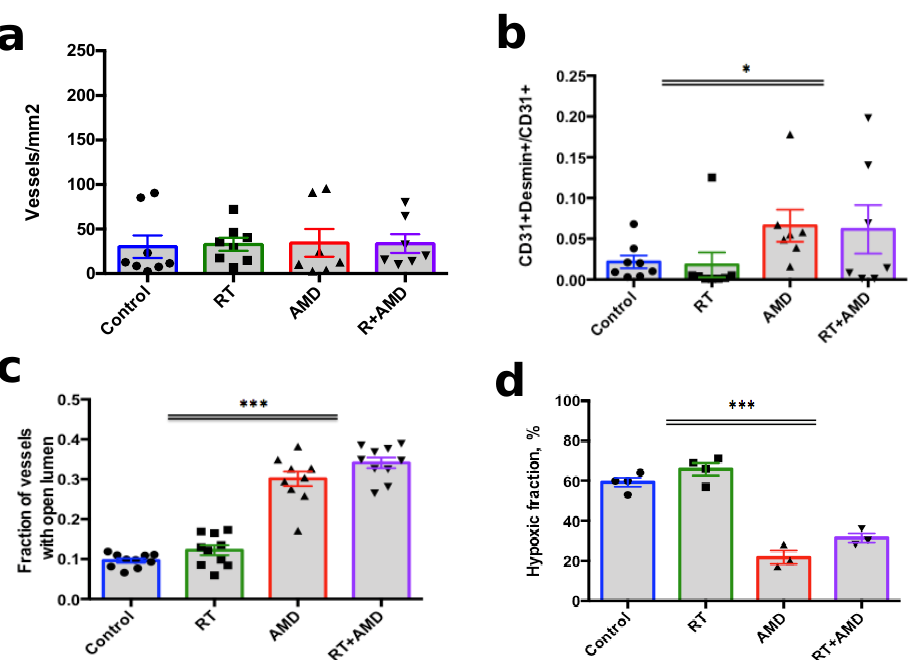
Figure 5. Effects of AMD3100 on tumor vasculature in bony PtenSmad4-null mPCa tissue evaluated by immunofluorescence (IF). ( a – c ) The density of vessels ( a ), the fraction of mature vessels ( b ), and the fraction of vessels with open lumens ( c ) were measured by IF for CD31 and desmin. ( d ) Expression of the hypoxia marker CA-IX measured by IF. Tissue collection for analysis was performed 4 days after radiotherapy (RT) and/or AD3100 treatment. * p < 0.05; *** p < 0.001.